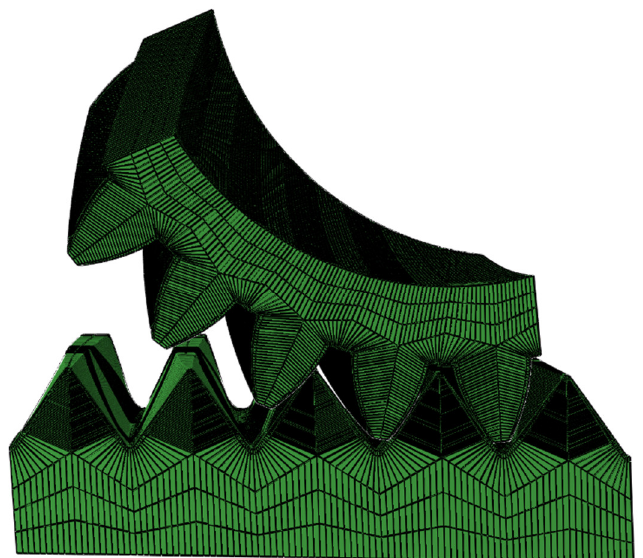
Figure 6. Five-tooth model of finite element simulation.